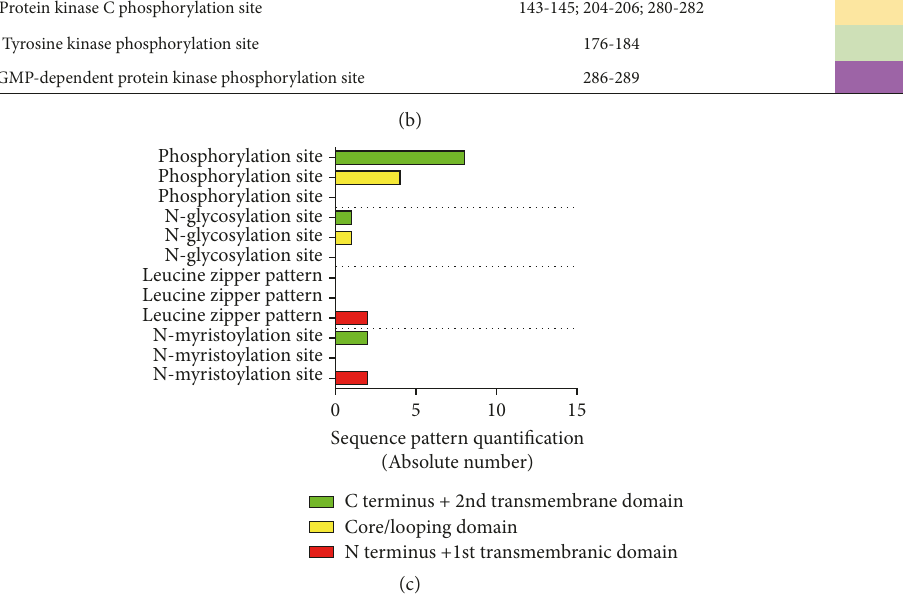
Figure 12: Theoretical posttranslational modifications of seipin. (a) Prosite [46] and Pfam [47] predictions for posttranslational modifications and conserved domains of seipin, respectively. (b) Residue patterns highlighted in (a). (c) Quantification of patterns. Even as theoretical predictions, the N-glycosylation site was already proven to occur and to be affected by the mutations N88S and S90L